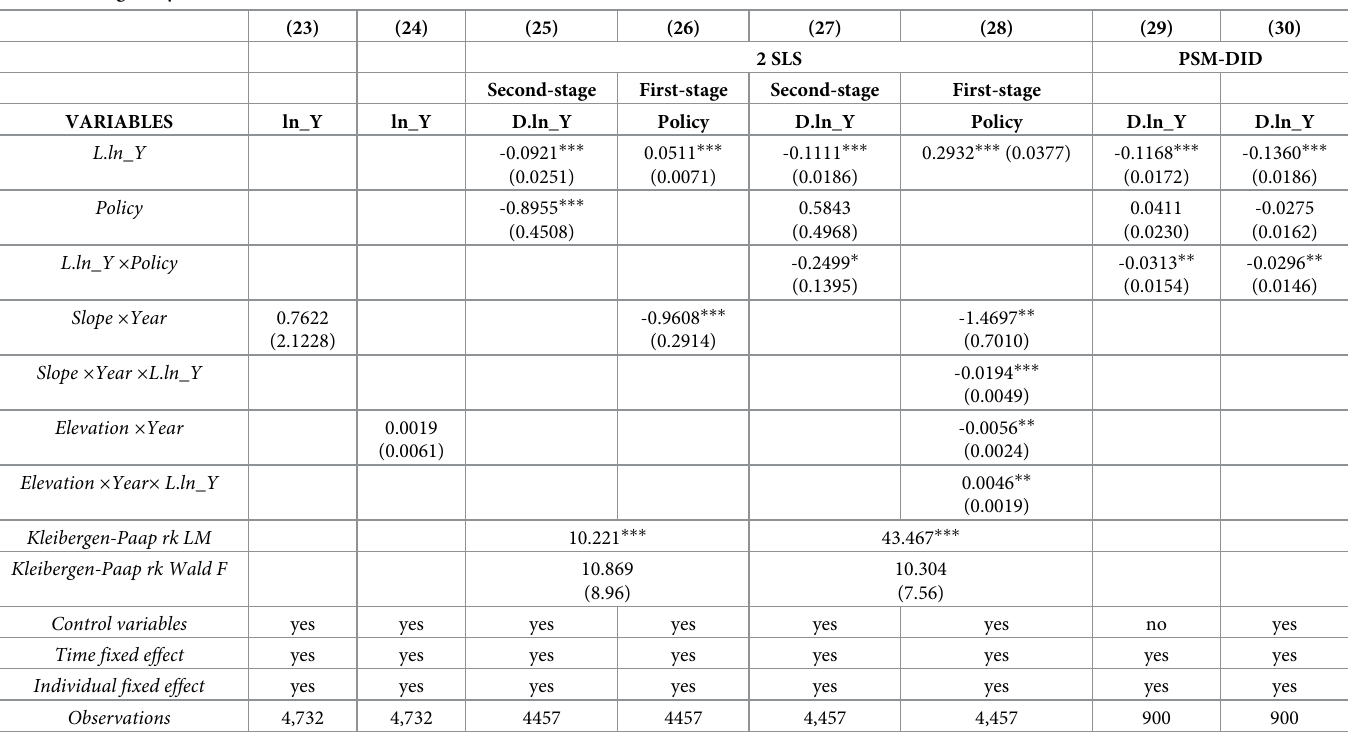
Table 7. Endogeneity